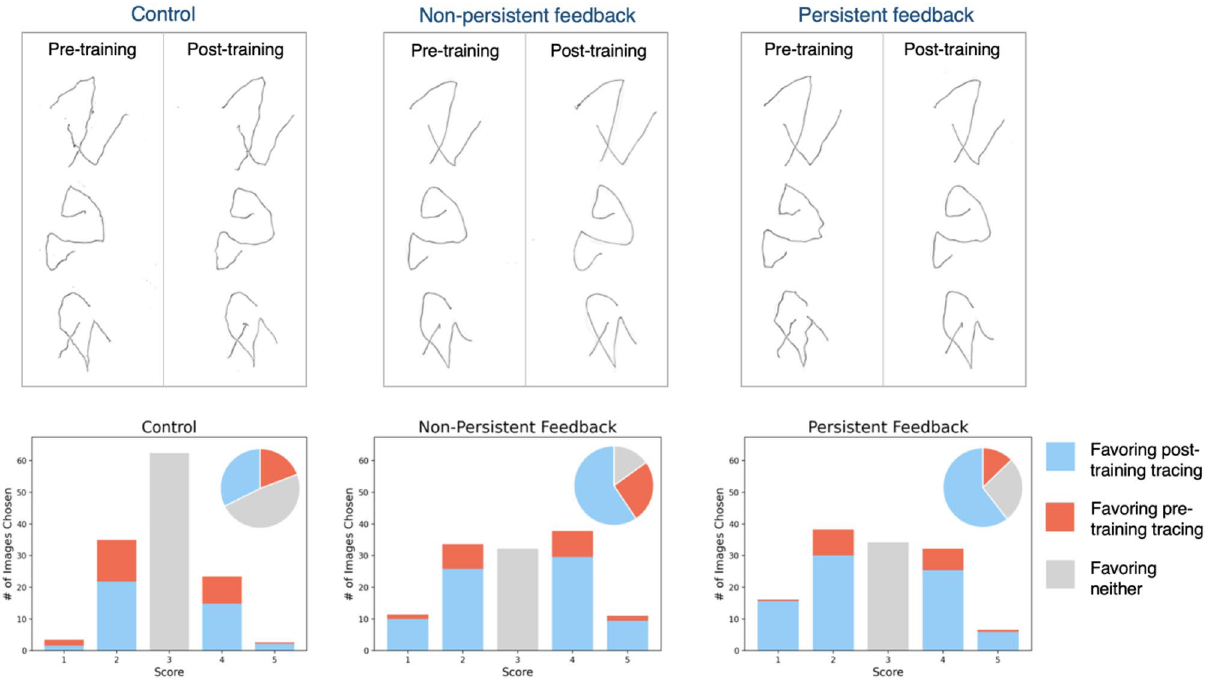
Figure 4. (Upper panels) Sample tracings pairs that ‘steadiness’ raters were shown. Each pair shows one pre- (left) versus post- (right) training tracing of one subject from each group. Visual inspection shows that, in terms of line steadiness, both the Persistent and Non-Persistent training resulted in improvements in tracing steadiness, whereas Control group subjects did not improve. (Lower panels) Average Steadiness scores of five raters. Control group’s tracings were rated mostly as equal steadiness when comparing pre- and post-training tracings, while the other two subject groups had less indeterminate ratings and more post-training tracings identified as